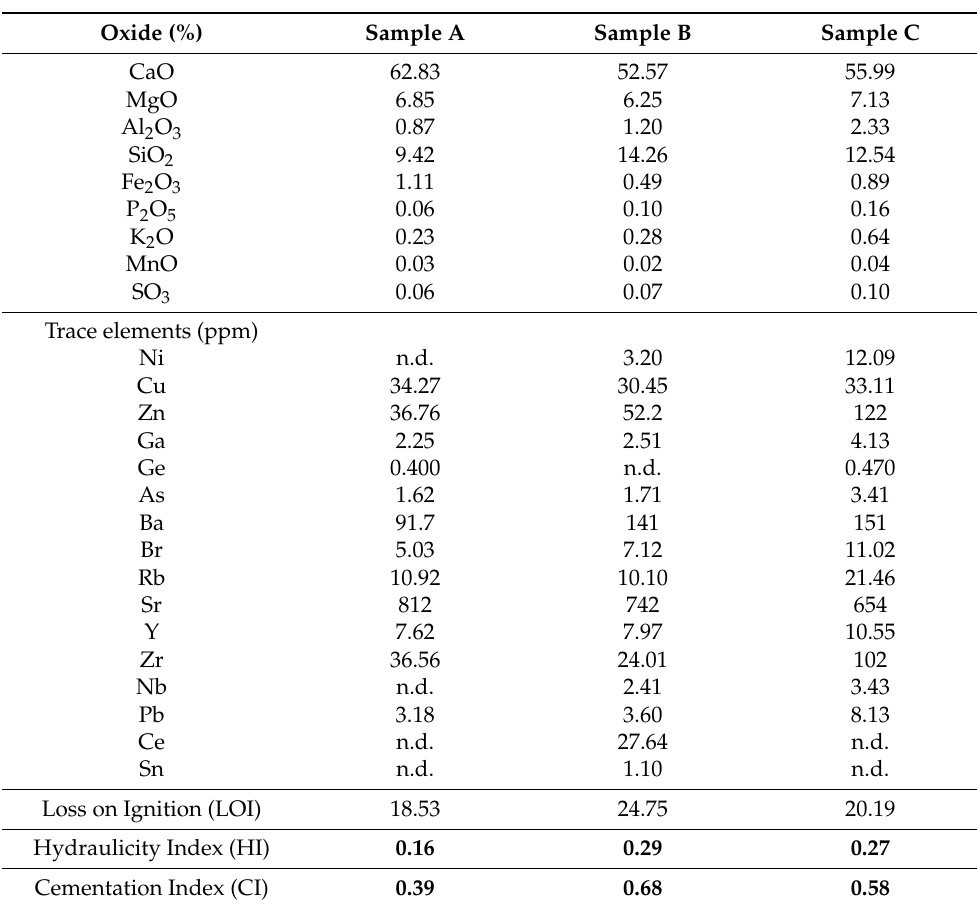
Table 3. XRF data of the major oxides present in the A, B, and C mortar samples, expressed in weight (%), and trace elements expressed in ppm (n.d.: not